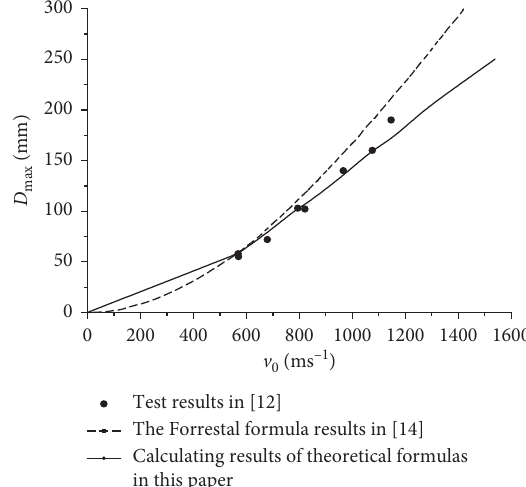
Figure 4: Comparison of penetration depth.